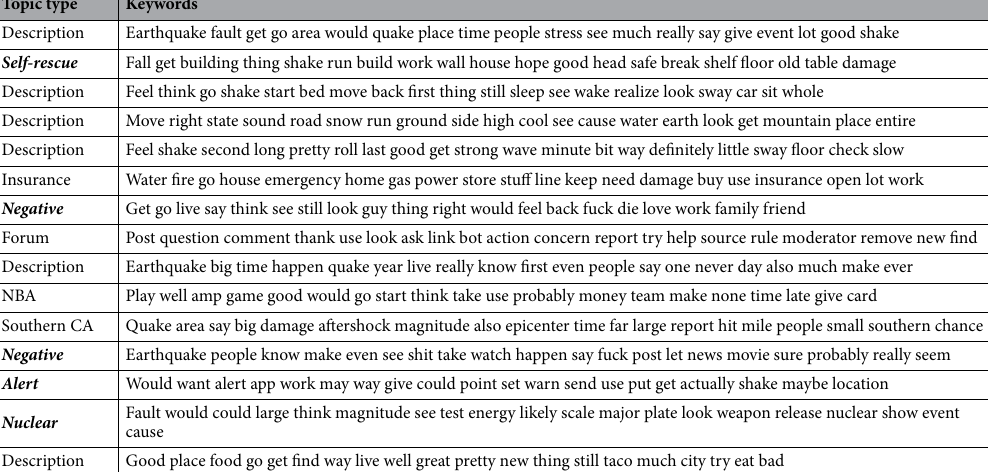
Table 1. Top 15 topics on Reddit after the M6.4 foreshock using GPU-PDMM. Topics on Twitter can be found in 7